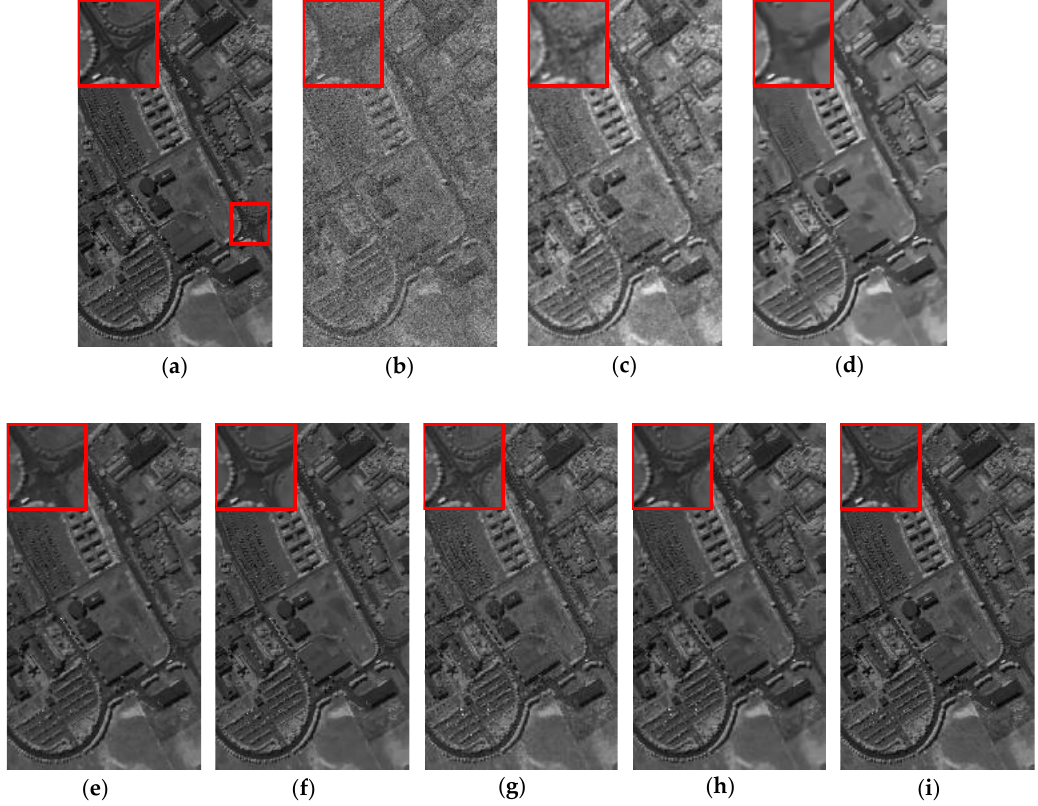
Figure 5. Restored images of band 101corruptedwith Gaussian noise: ( a ) clean HSI; ( b ) noisy HSI; ( c ) KSVD; ( d ) BM3D; ( e ) ANLM3D; ( f ) BM4D; ( g ) LRMR; ( h ) DDL3+FT; ( i ) Our method.